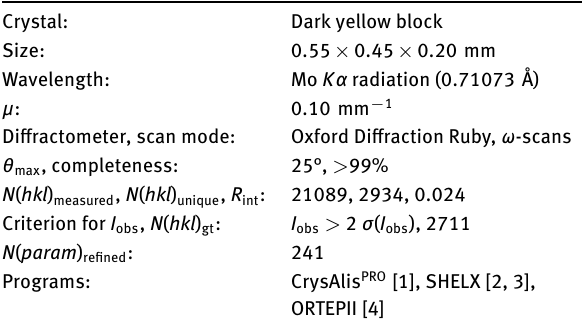
Table 1: Data collection and